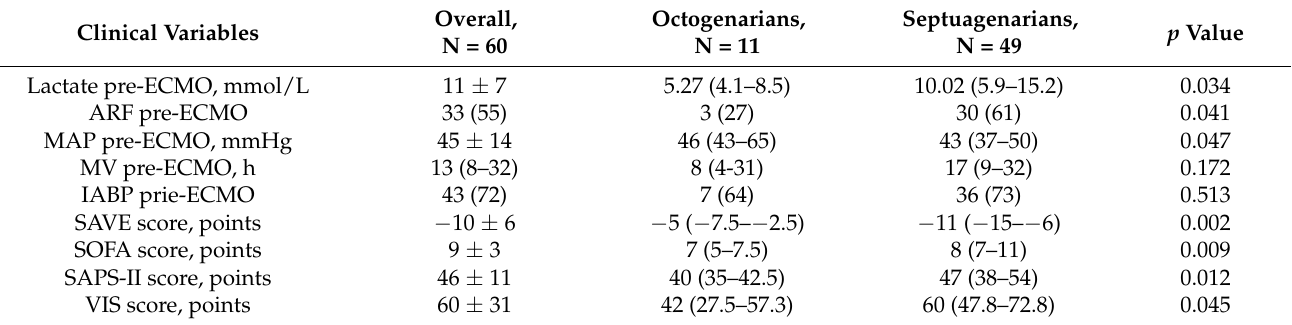
Table 3. Pre-ECMO